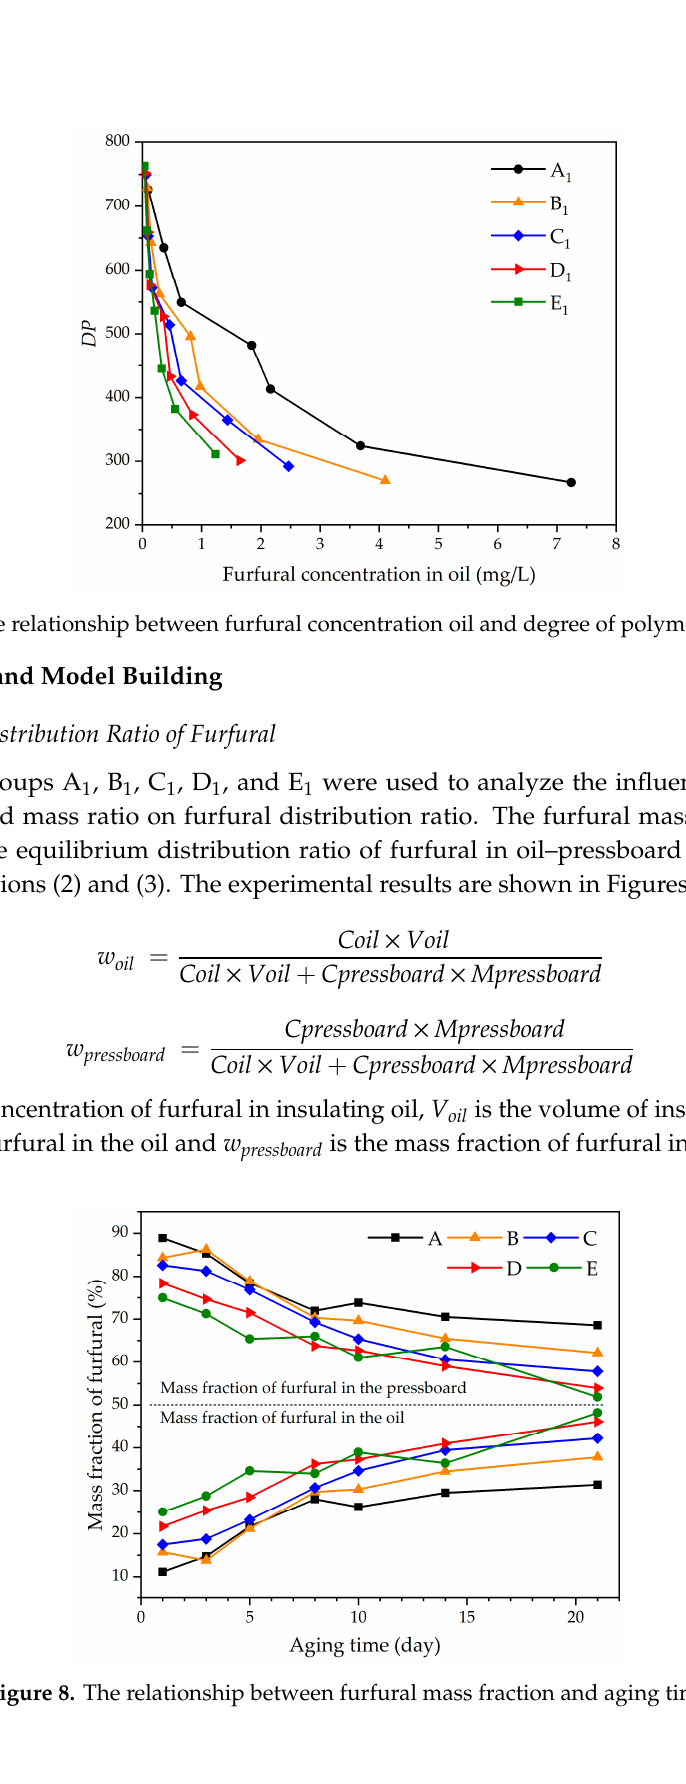
Figure 8. The relationship between furfural mass fraction and aging time.